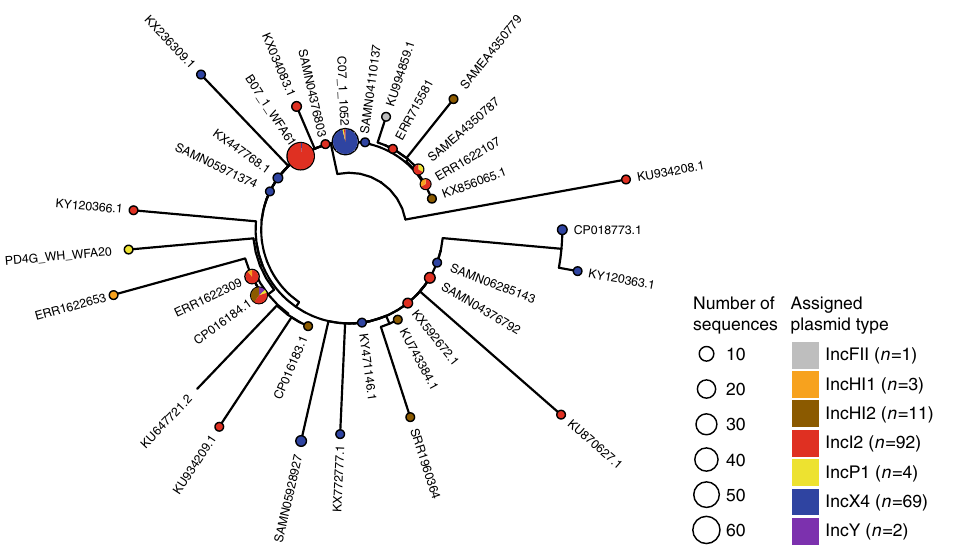
Fig. 5 The distribution of plasmid types shown on the transposon phylogeny. Maximum parsimony tree (homoplastic sites removed, midpoint rooted, as in Fig. 4) based on the composite transposon alignment for 172 sequences containing a plasmid replicon on the same contig i.e. those with an assigned plasmid type (color). IncI2 and IncX4 are the most common plasmid types. An example sequence ID is shown for each unique the short-read archive, we found not a single mcr-1 sequence outside the IS Apl1 transposon background. IS Apl1 was fi rst identi fi ed in the pig pathogen Actinobacillus pleuropneumoniae 31 suggesting that it may also have been an ancestral host for A . pleuropneumoniae isolates have been described. The phos- phoethanolamine transferase from Paenibacillus sophorae has